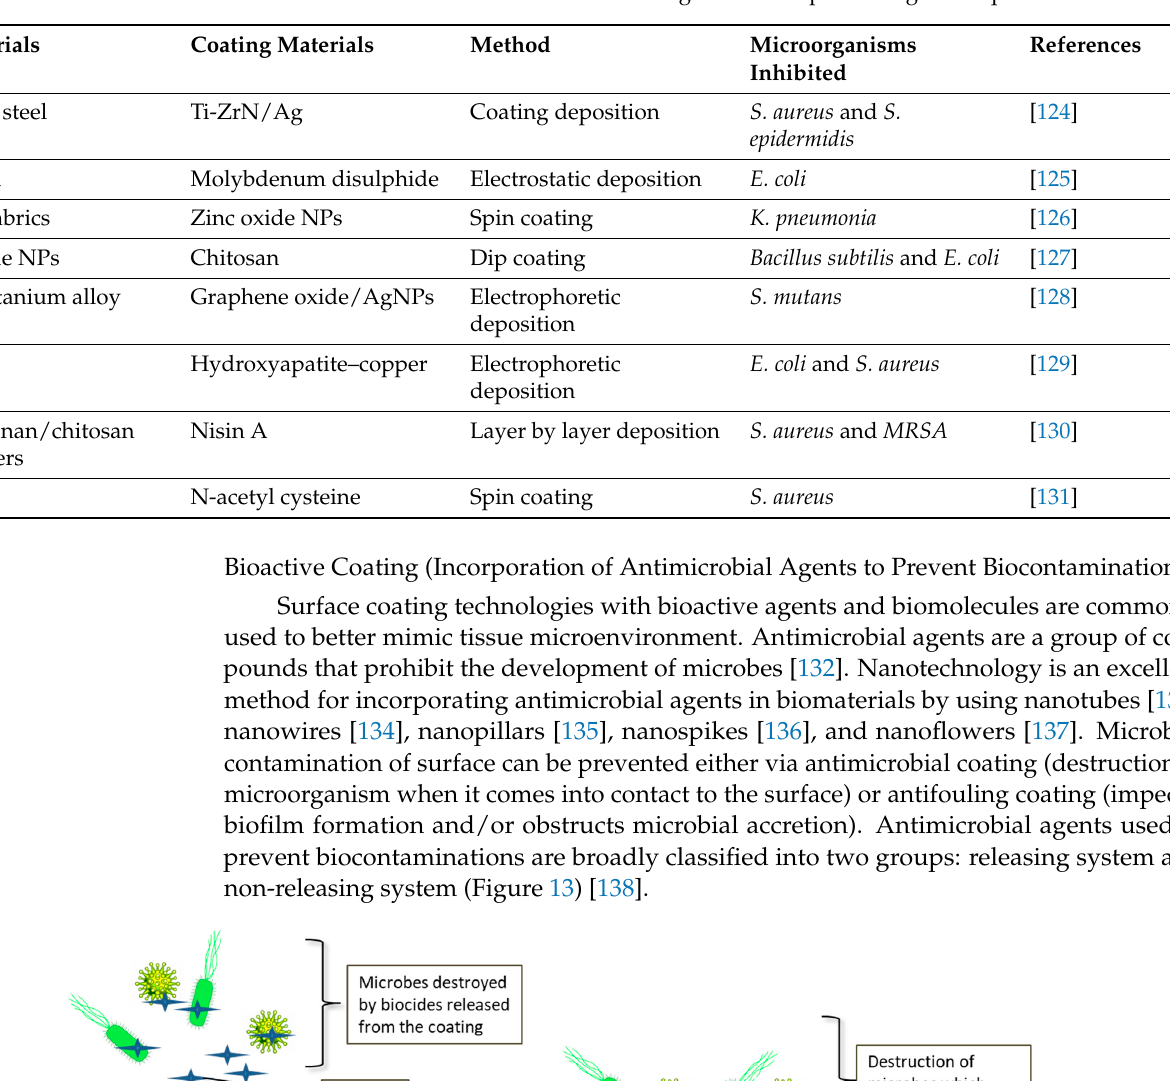
Table 4. Some of the biomaterials coated with antimicrobial agents via simple coating technique.